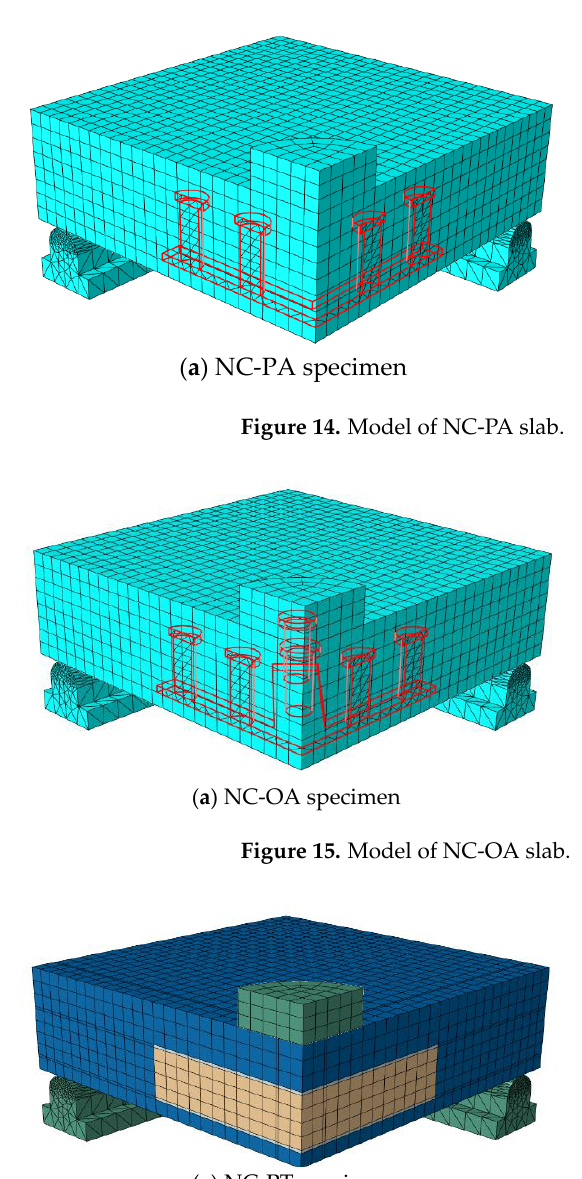
Figure 16. Model of NC-PT slab.